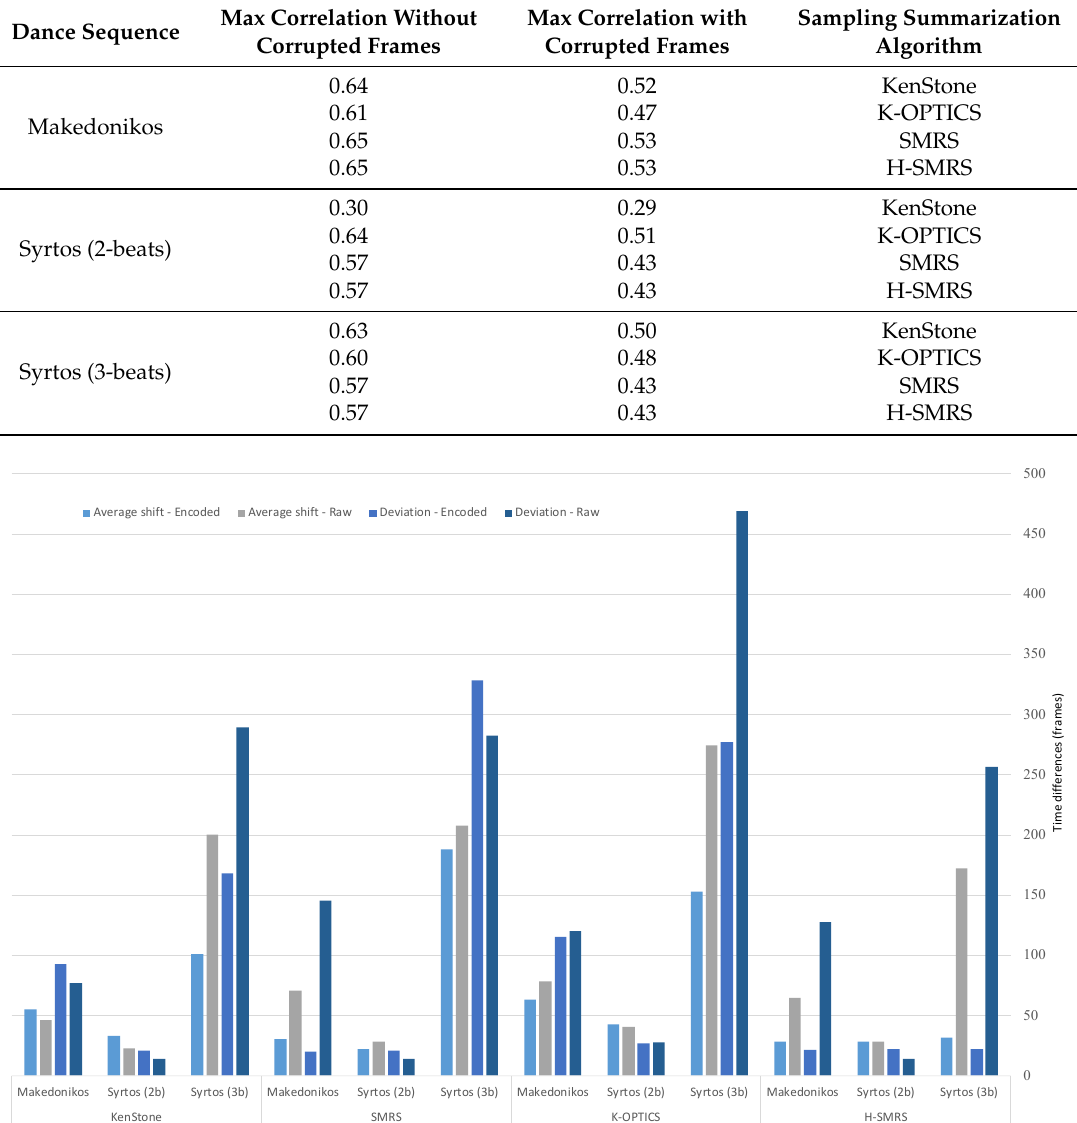
Table 2. Maximum correlation coefficient scores ( ρ max dance sequences.